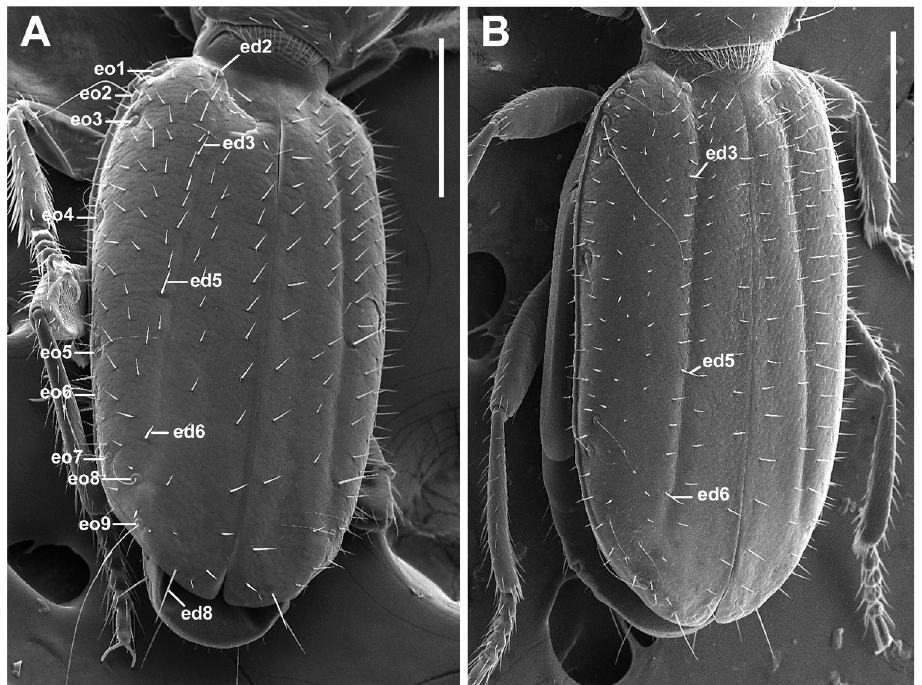
Figure 4. SEM illustrations of chaetotaxy of elytra, dorso-lateral aspect, of Pelodiaetus species. A P. sul- catipennis B P. nunni . Abbreviations: ed2 – scutellar seta; ed3 – 1 st discal seta; ed5 – 2 nd discal seta; ed6 – 3 d discal seta; ed8 – apical seta; eo1–9 – setae 1–9 from the umbilical series. Scale bars 0.2 mm. A key for identification of adult representatives of Pelodiaetus from New Zealand 1 Eyes lacking (Fig. 6). Posterior angles of pronotum distinct, projected out- wards, without denticle anterior to them (Fig. 2A, B). Prosternal process dilating to blunt apex (Fig. 2C, D). Elytra with longitudinal grooves and uneven discal setae: 1 st discal seta not distinguishable from surrounding vesti- ture, noticeably shorter than distinct 2 nd and 3 d discal setae, which are clearly visible (Fig. 4). Umbilicate series of nine pores (Fig. 4) ............................... 2 – Other combination of characters...... other genera of New Zealand Anillini 2 Male with distal sclerites (ds) of internal sac long (Fig. 7A), formed as a long flagellum with strongly sclerotized compact basal area. Females with spermatheca moderately elongated, > 2.5 times longer than wide (Fig. 7D). Beetles from the Port Hills Range (Fig. 8, white circles), of coastal central- eastern Canterbury ............................................................ P. nunni sp. nov. – Males with distal sclerites (ds) of internal sac short (Fig. 7E), not longer than a half of the length of median lobe; sclerites without compact basal conges- tion. Females with spermatheca slightly elongated, <2.0 times longer than wide (Fig. 7H). Beetles from Stewart Island, Southland, Otago and foothills of southern Canterbury (Fig. 8, yellow circles) ........ P. sulcatipennis